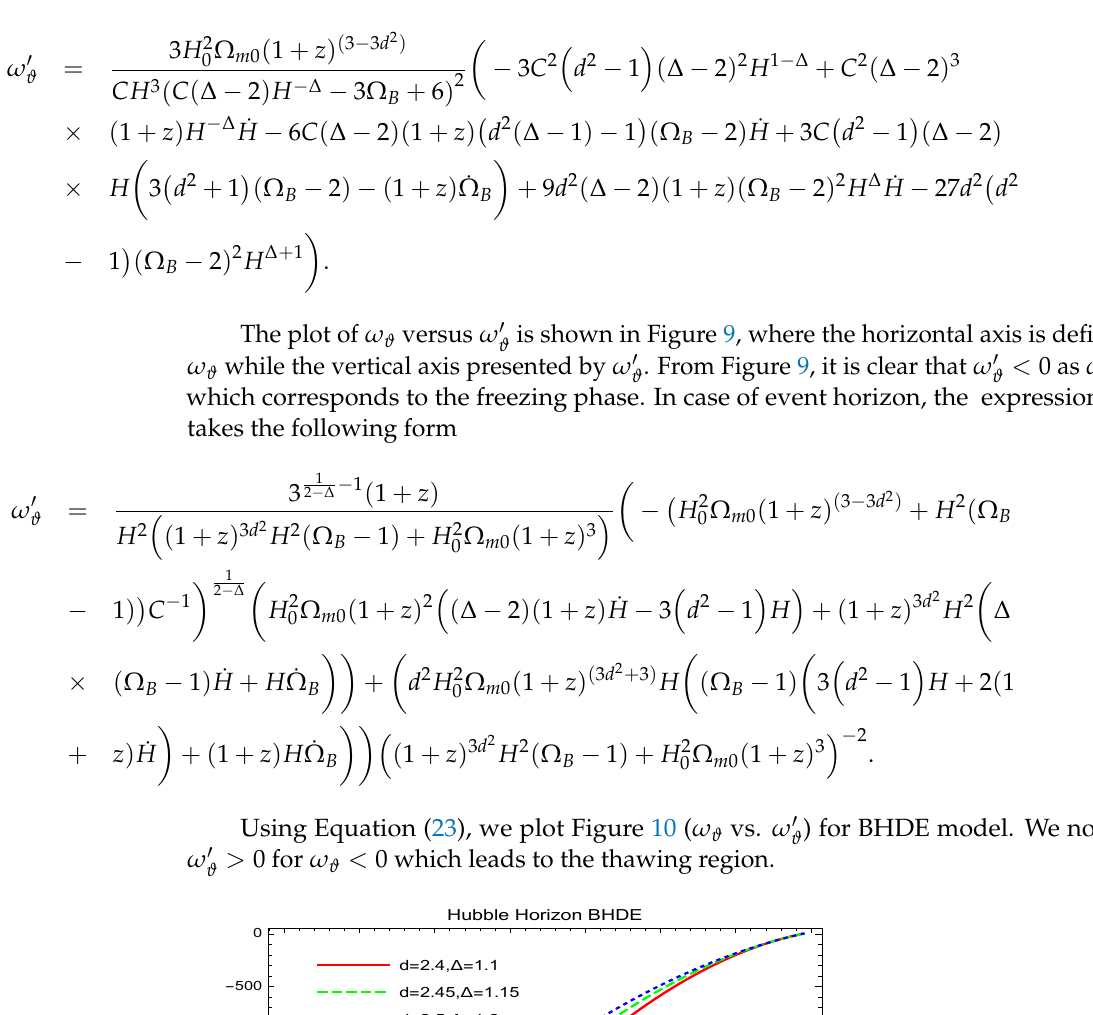
is shown in Figure 9, where the horizontal axis is defined by ϑ . From Figure 9, it is clear that ω (cid:48) ϑ